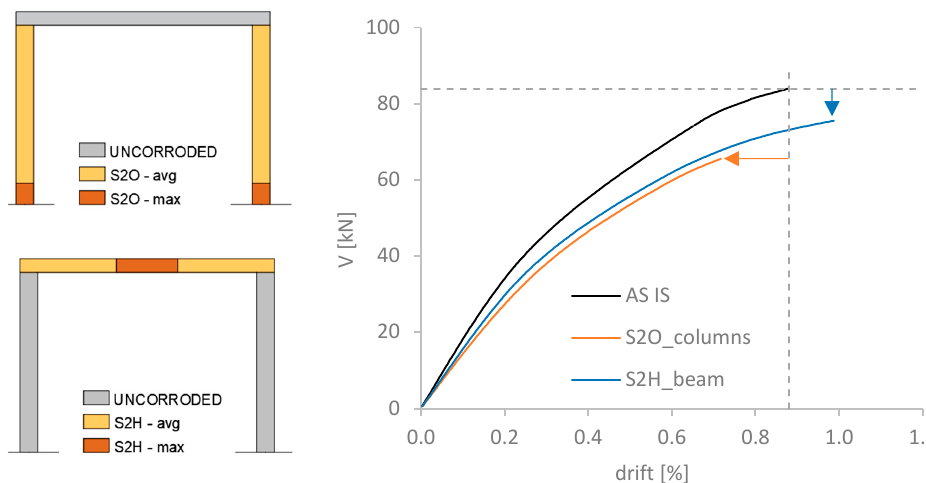
Figure 13. Capacity curves of a 2D RC frame in the as-is condition, with a corrosion pattern associated with the school building (S2O_columns) and with the private car park (S2H_beam) described in Section 3. The curves are interrupted in correspondence with a brittle failure of the elements.